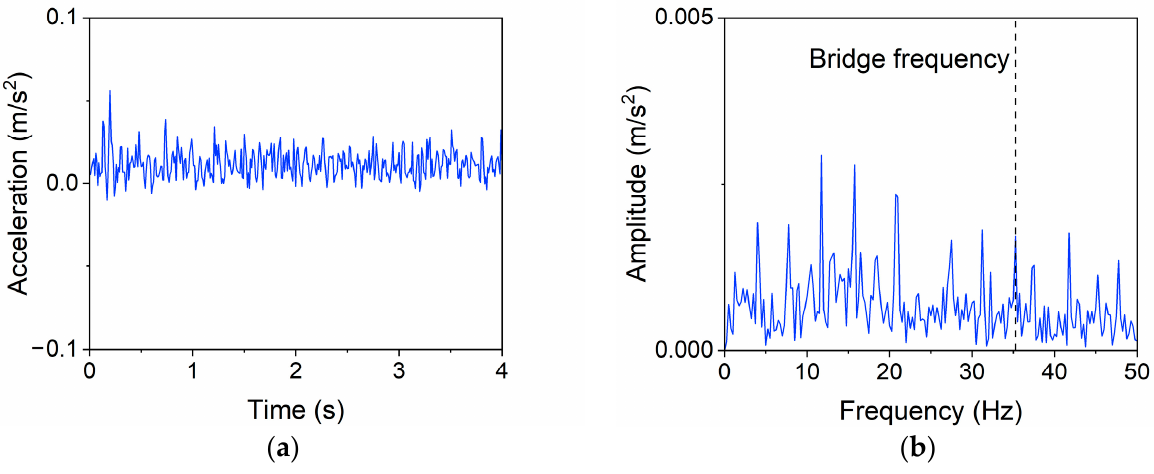
Figure 16. Representative signal after pooling. ( a ) Time domain, ( b ) Frequency domain.